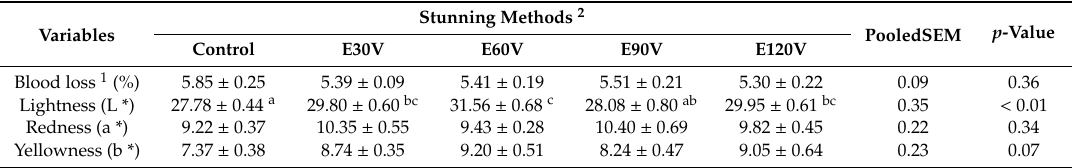
Table 3. E ff ect of electrical stunning (ES) methods on bleed-out e ffi ciency and goose liver color on day 0 #